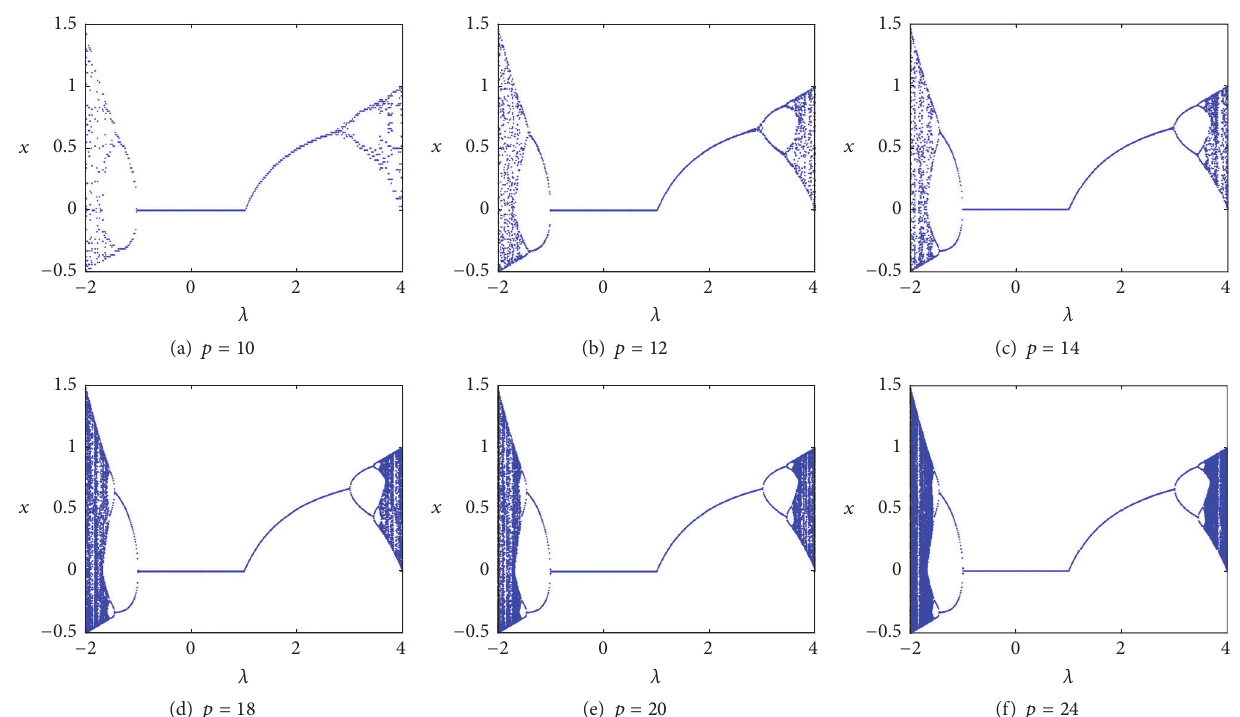
Figure 5: Bifurcation diagram of 𝑓 3 (𝑥) versus the control parameter 𝜆 for different values of bus size starting at 𝑥 0 = 0.5 .